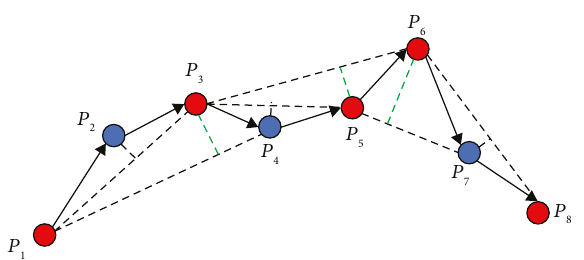
Figure 4: Illustration of the sliding window (SW)